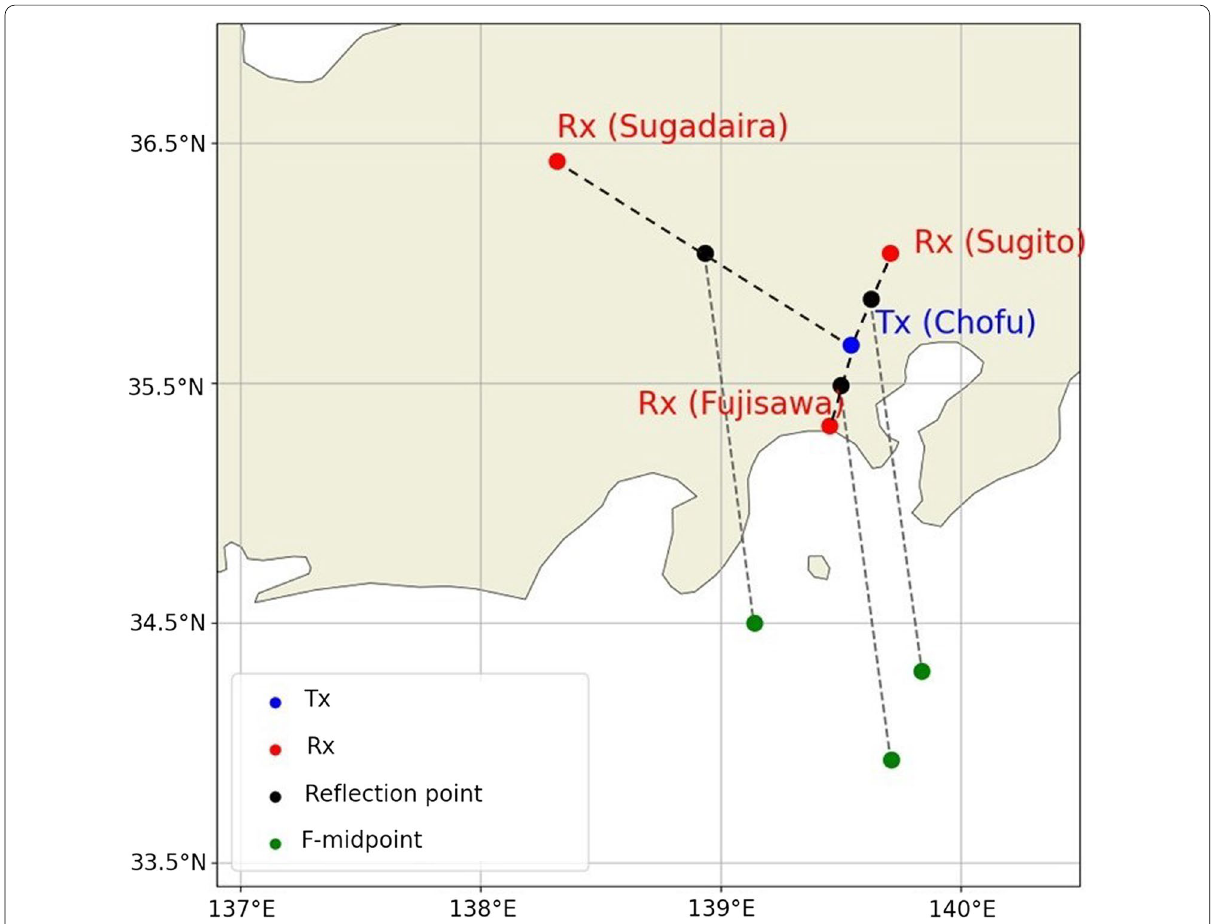
Fig. 2 Location of the Tx (blue circle), Rxs (red circles), reflection points (i.e., mid-points between Tx and Rx stations, black circles) and the corresponding F region (300 km altitude) mid-points derived by tracing along the magnetic field (green